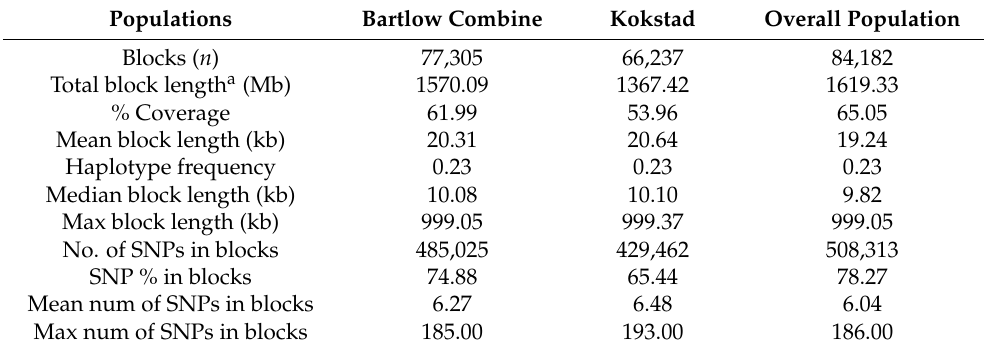
Table 3. Summary statistics for haploblocks across Bartlow Combine, Kokstad, and overall Nguni cattle